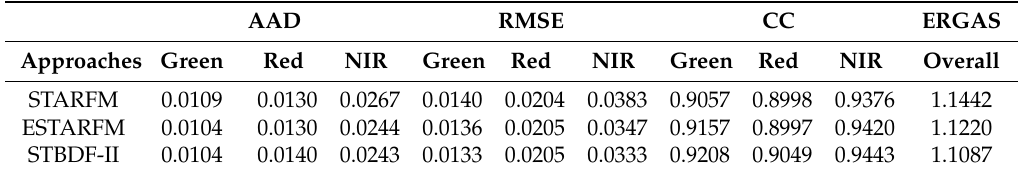
Table 4. Quantitative metrics of the fusion results applied to the Panyu